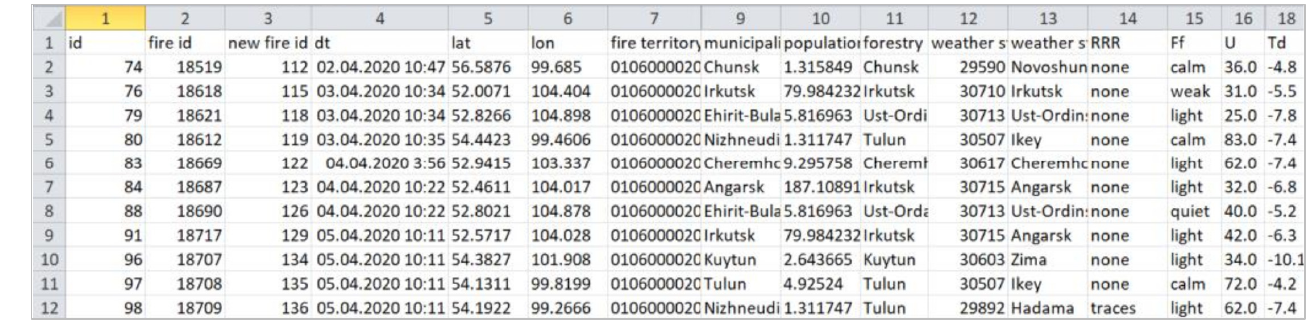
Figure 6. A fragment of the decision table with forest fire data (RRR, the amount of precipitation; Ff, wind strength; U, relative humidity of the air; Td, dew point temperature).